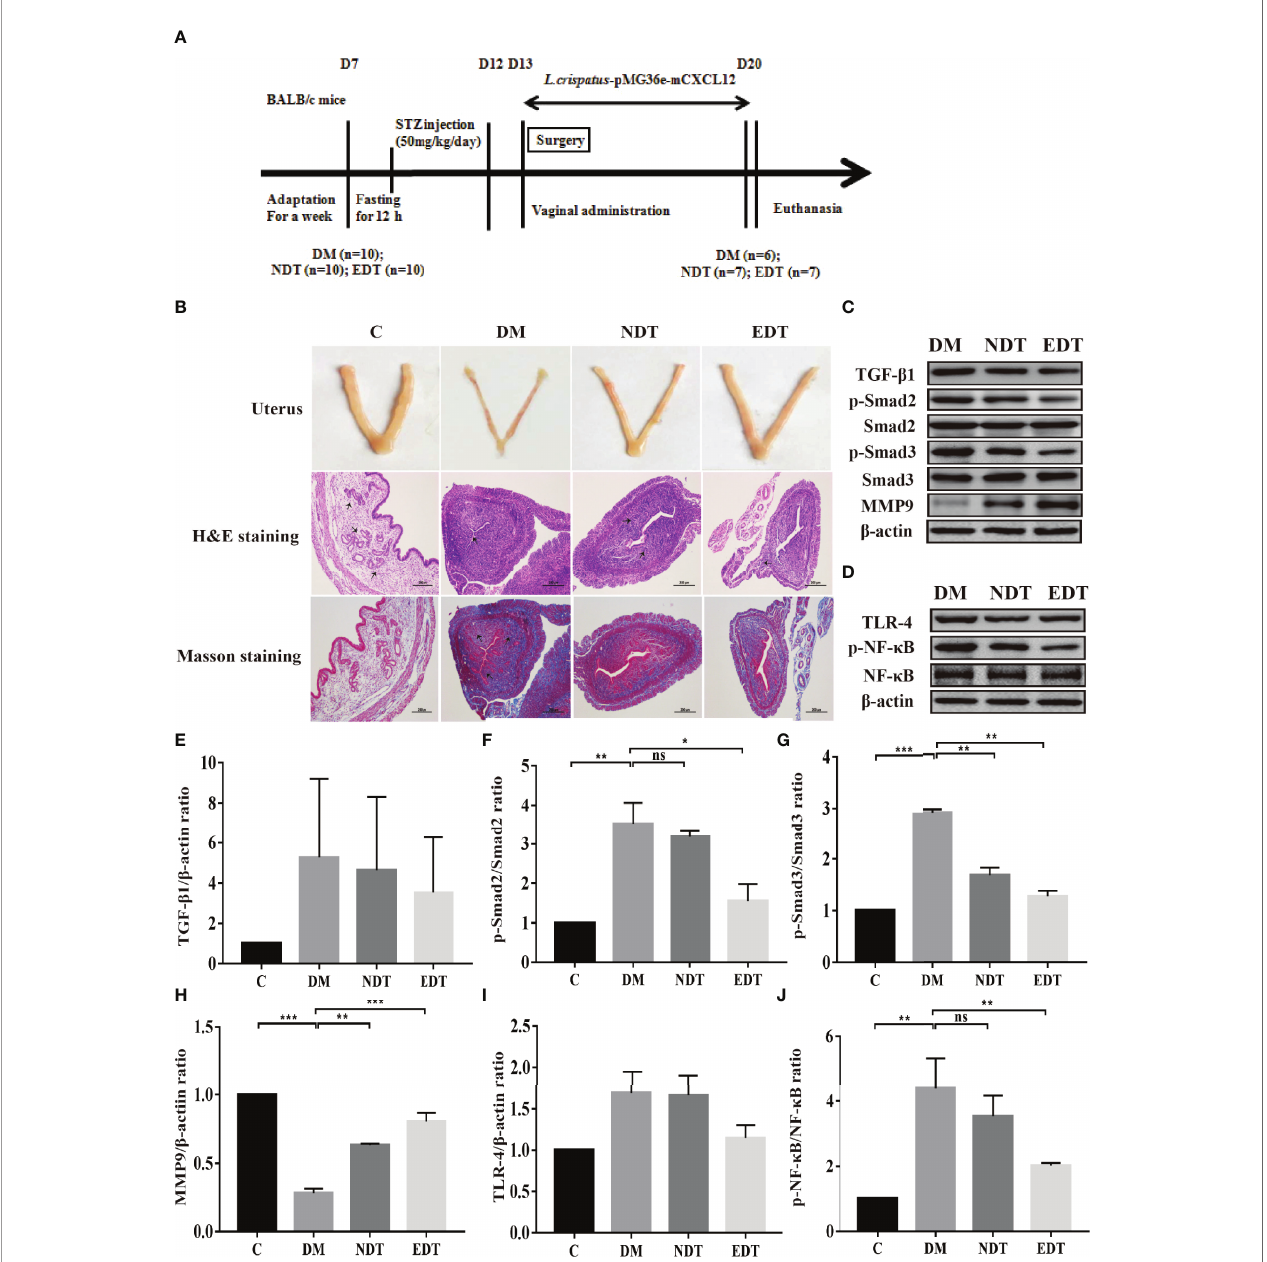
FIGURE 4 | Effect of L. crispatus -pMG36e-mCXCL12 on the expression of proteins associated with the TGF- b 1/Smads and TLR4/NF- k B signalling pathway in intrauterine adhesion mice with diabetes. (A) Experimental scheme to evaluate the effects of L. crispatus -pMG36e-mCXCL12 on the prevention of intrauterine adhesion in diabetic mice. (B) H&E staining was used to observe uterine in fl ammation, and Masson staining was used to observe collagen deposition in the uterine tissue of intrauterine adhesion mice with diabetes (magni fi cation: × 100). (C) Expression of fi brotic-related proteins in the uterine tissue of intrauterine adhesion mice with diabetes. (D) Expression of in fl ammatory-related proteins in the uterine tissue of intrauterine adhesion mice with diabetes. Effect of L. crispatus -pMG36e- mCXCL12 on fi brotic-related TGF- b 1 (E) , p-Smad2/Smad2 (F) , p-Smad3/Smad3 (G) , MMP-9 (H) proteins in the uterine tissue of intrauterine adhesion mice with diabetes. Effect of L. crispatus -pMG36e-mCXCL12 on in fl ammatory-related TLR4 (I) , p-NF- k B/NF- k B (J) proteins in the uterine tissue of intrauterine adhesion mice with diabetes. C group, Control group; DM group, laparotomy was used to construct a model of intrauterine adhesion mice with diabetes; NDT group was treated with L. crispatus for intrauterine adhesion mice with diabetes; EDT group was treated with L. crispatus -pMG36e-mCXCL12 for intrauterine adhesion mice with diabetes. One-way ANOVA analysis was used for statistical analysis and all data are presented as mean ± standard deviation (SD). ns, P > 0.05; *P < 0.05; **P < 0.01; ***P <